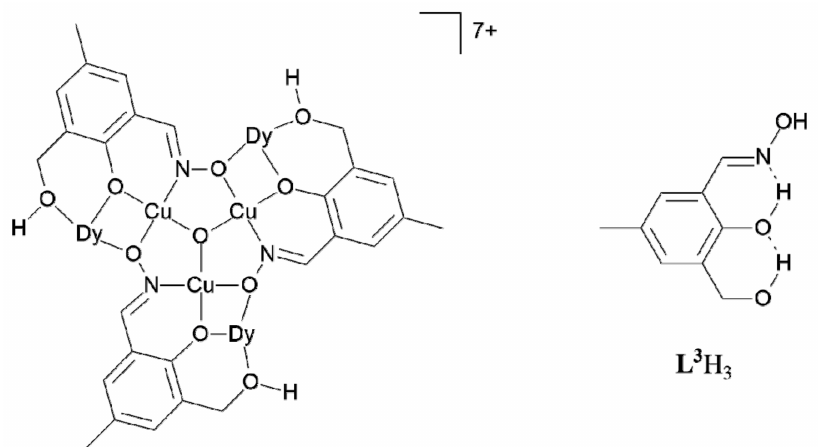
Figure 4. The [Cu 3 Dy 3 ( L 3 H)O] 7+ component of the heterometallic cluster [Cu 8 Dy 3 ( L 3 H) 6 ( µ 4 -O) 2 Cl 6 (H 2 O) 8 ]Cl 8 formed by the 2-hydroxymethyl-substituted phenolic oxime L 3 H 3 . All three Dy atoms are displaced to the same side of the Cu 3 triangle